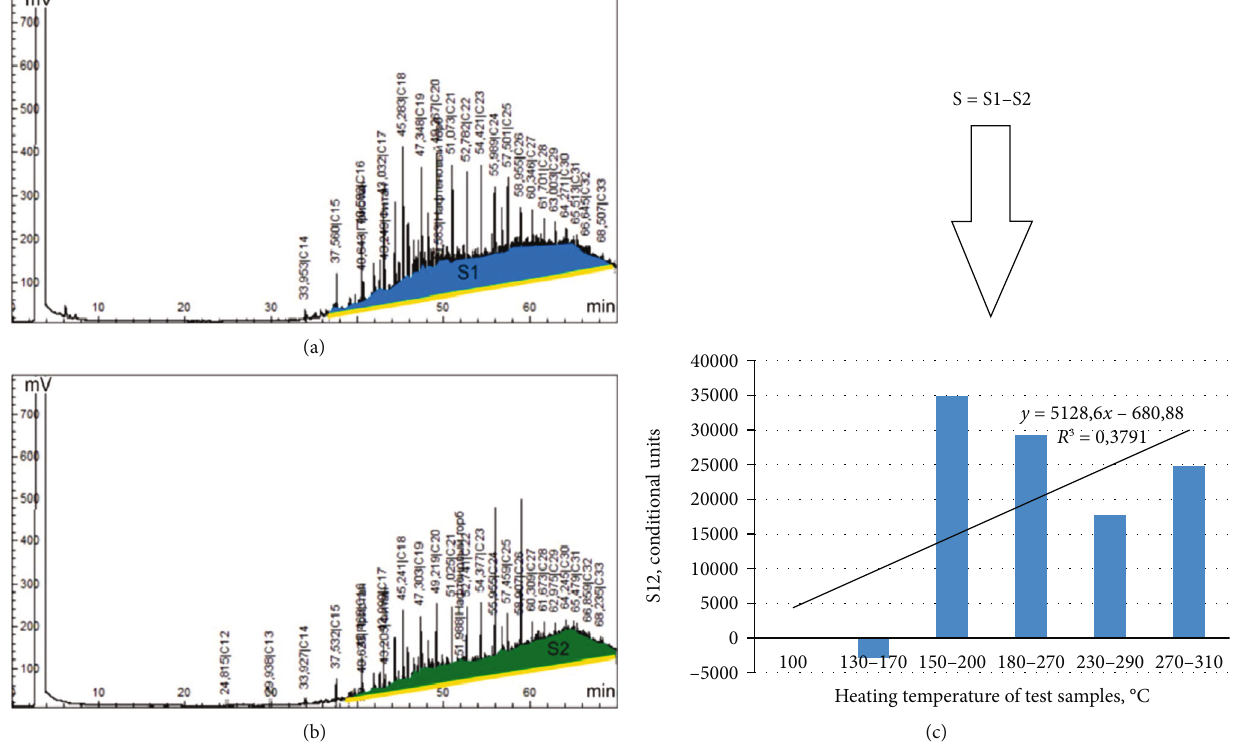
Figure 5: A decline in the complex mixed naphthenes after the source rock (shale) was heat-treated under the magnetic fi eld: (a) bitumoid chromatogram after the thermal treatment without magnetic fi eld; (b) bitumoid chromatogram after the thermal treatment under a magnetic fi eld, and (c) a histogram of the di ff erence in the naphthene “ hump ” (total naphthenes in bitumoid) for samples heat-treated under a magnetic fi eld and with no magnetic fi eld